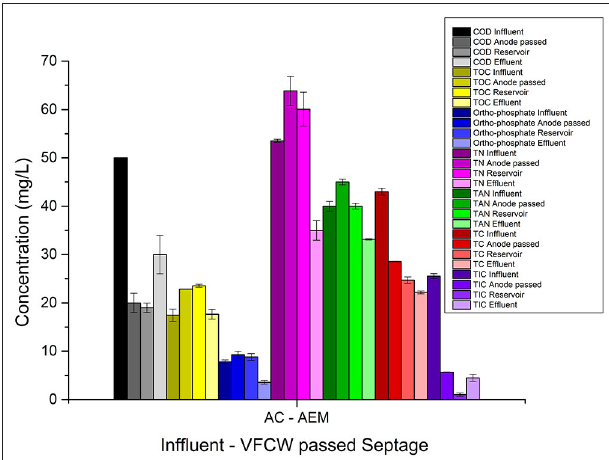
FIGURE 10 | Graphical representation of variation in wastewater parameters as the feed flows through the anode chamber and then through the cathode chamber via reservoir during electrolysis in AEM based ECR.